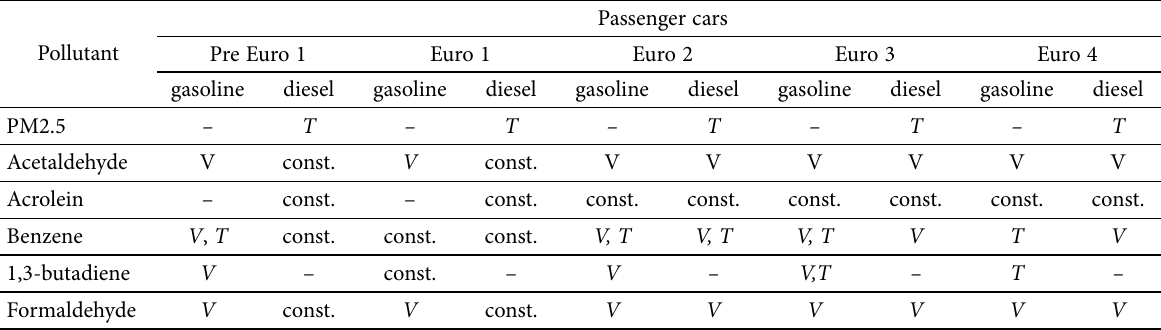
Table 1. Parameters considered for cold-start and hot emission factor quantification